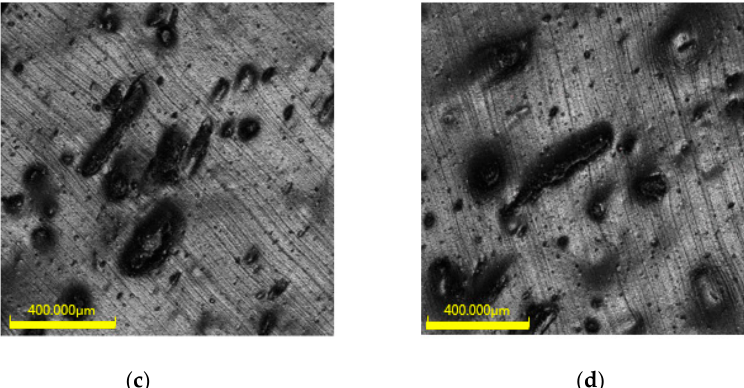
Figure 8. Images of areca fiber dispersion: ( a ) Untreated; ( b ) Si − 69; ( c ) KH − 550 and ( d ) KH − 570.